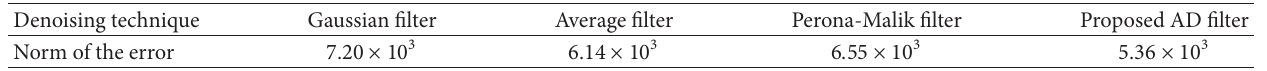
Table 2: Values of norm of the error image parameter for various noise reduction